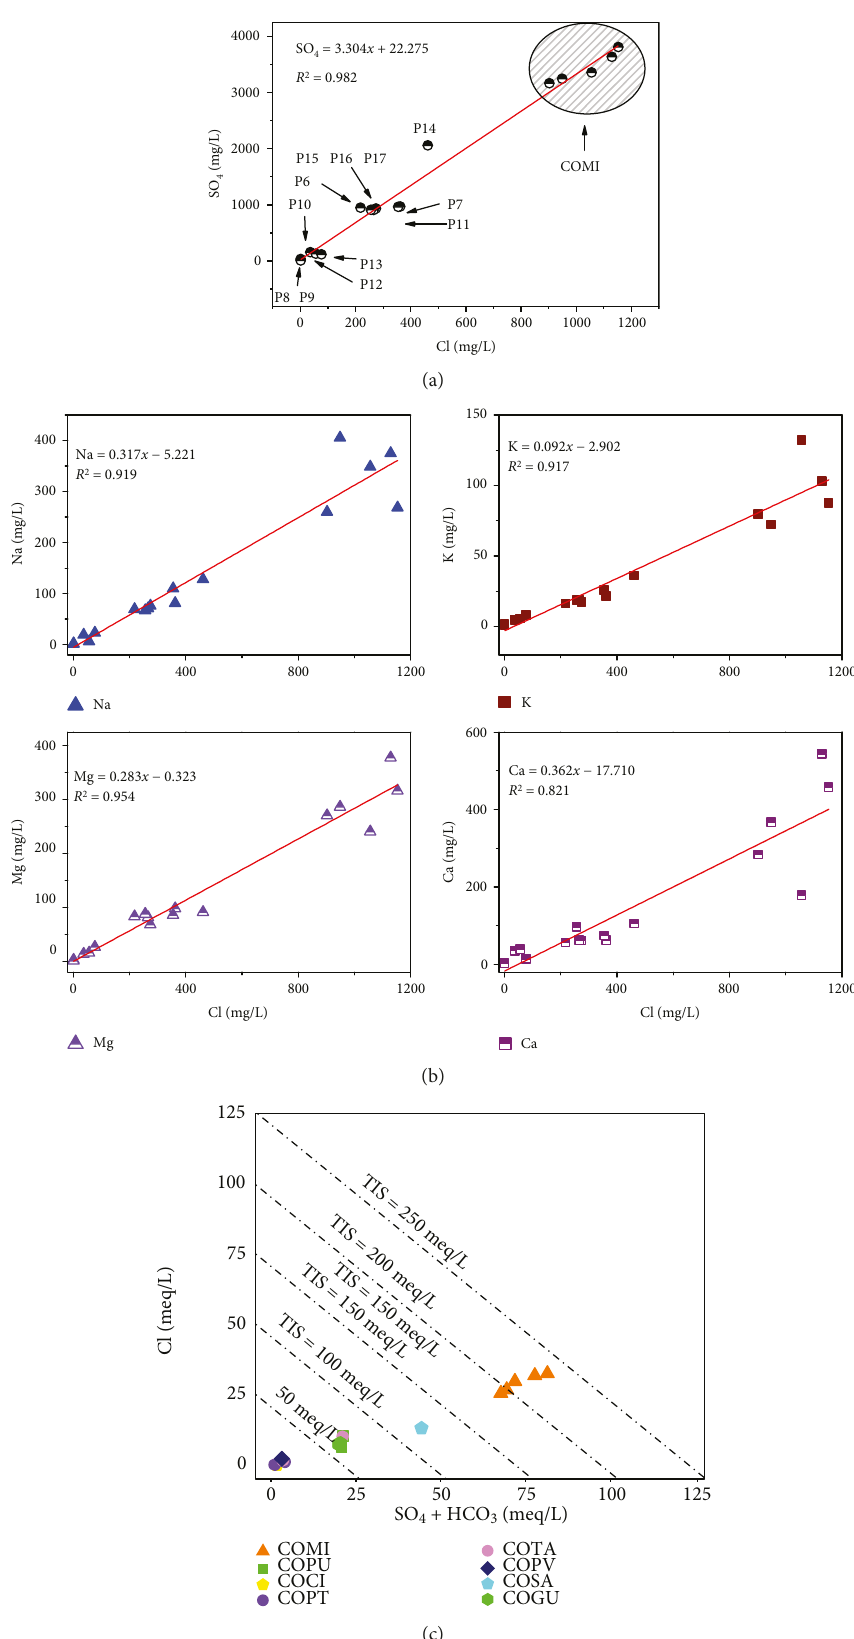
Figure 6: Correlation plots: (a) Cl vs SO